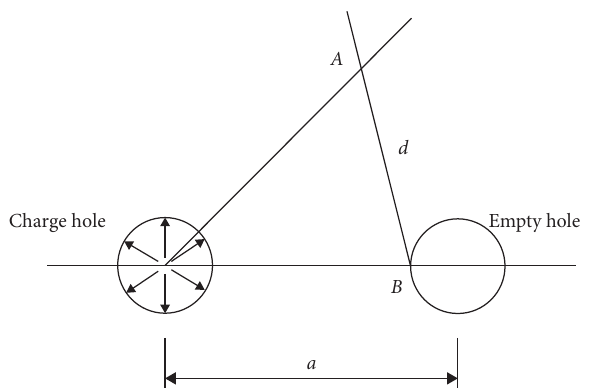
Figure 1: Relationship between empty hole spacing and crack